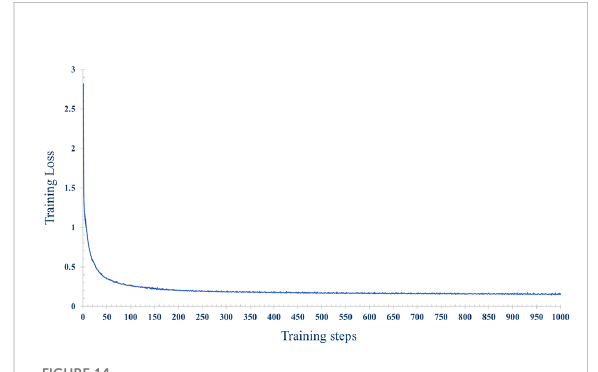
FIGURE 14 The change process of the loss, with the increase of training epochs, when the number of nodes is 5 in the hidden layer.